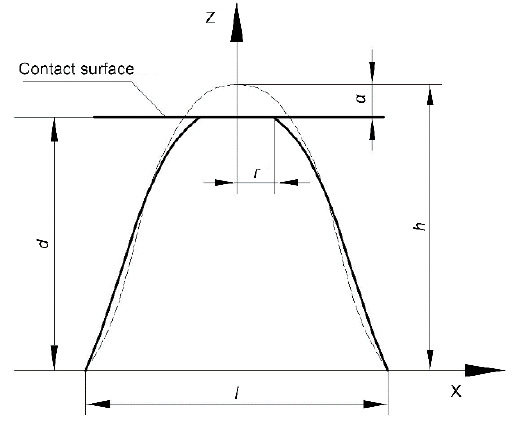
ff ness model of a single Figure 3. Microcontact stiffness model of a single asperity. Figure 3. Microcontact sti